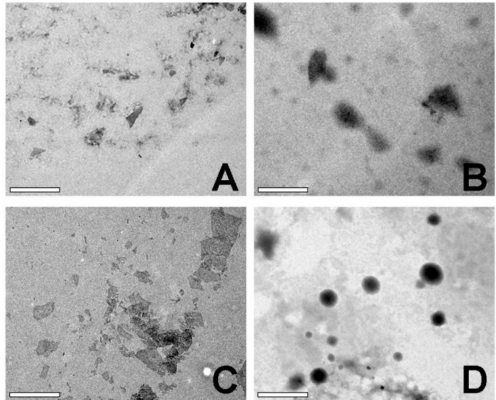
Figure 5. TEM images of ( A ) PEI-rGO, ( B ) PK 5 E 7 (PEI-rGO), ( C ) PEI-rGO / DOX, and ( D ) PK 5 E 7 (PEI-rGO / DOX). Scale bar = 0.5 µ m.